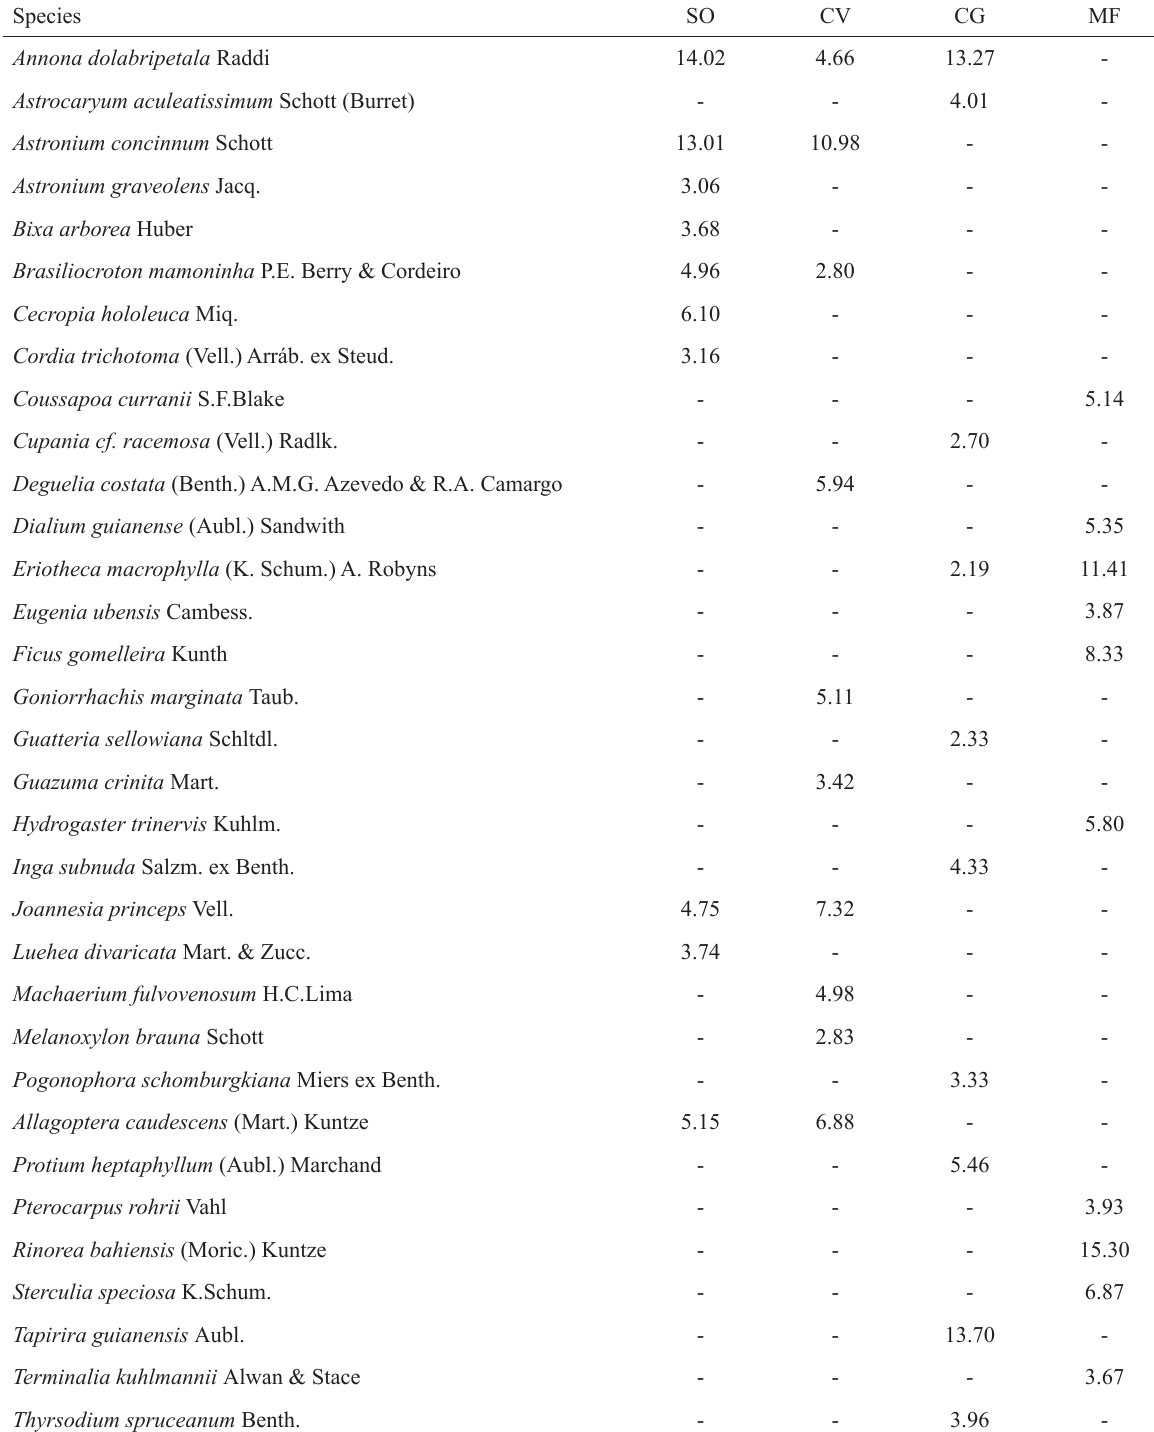
List of the 10 most important species in cover values in the three forest fragments Sooretama (SO, 14 years after fire), Córrego do Veado (CV, 25 years after fire), Córrego Grande (CG, 25 years after fire) and a mature forest (MF), State of Espírito Santo, Brazil. MF data from Paula and Soares (2011). Species